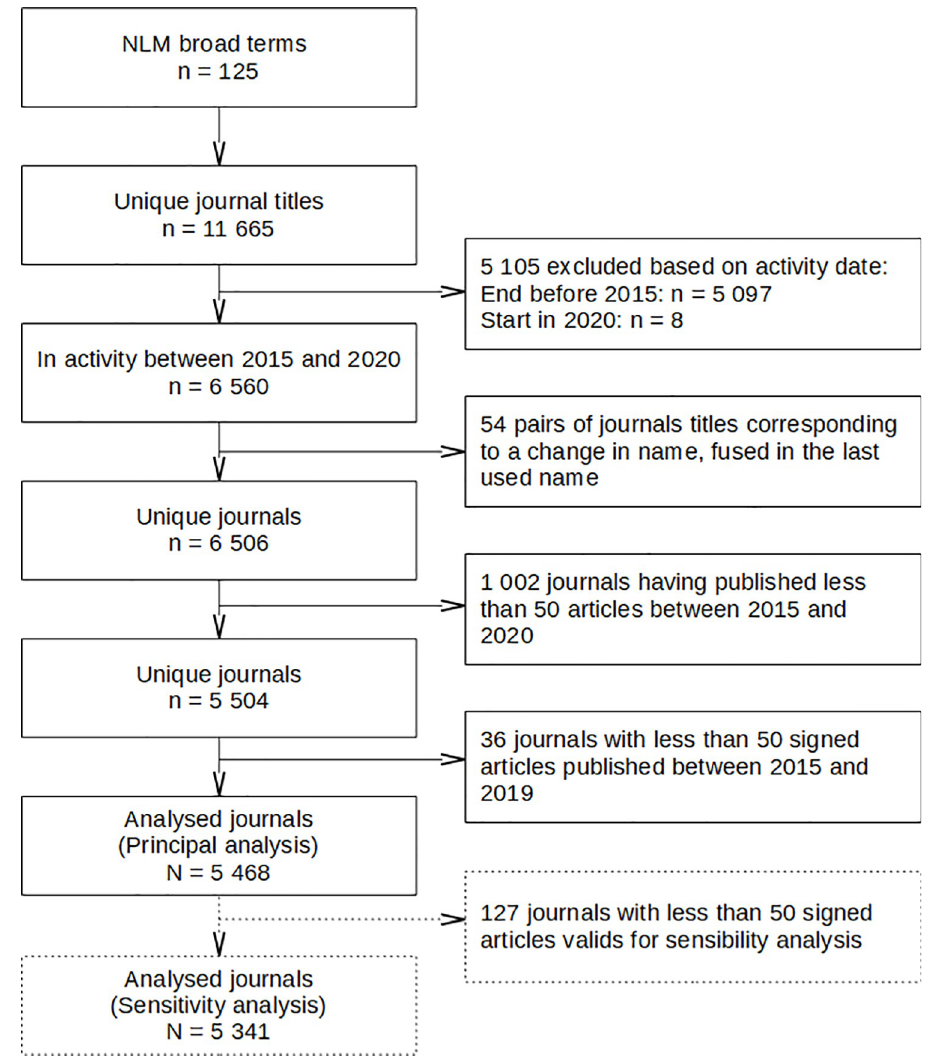
Fig 1. Flow chart of included journals. Selection flow chart for journals labeled with at least one “Broad Subject Term” in the NLM. NLM AU : AbbreviationlistshavebeencompiledforthoseusedinFigs 1 and 2 andTable 1 : Pleaseverifythatallentriesarecorrect : , National Library of